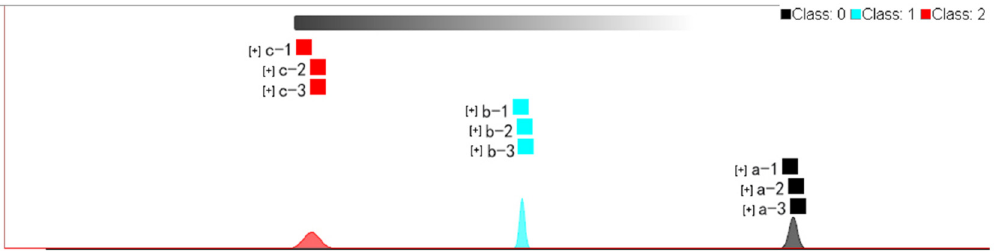
Figure 6. Fingerprint similarity based on Euclidean distance of different samples. a: Oil cistanche, b: blood cistanche, c: cistanche tubulosa in Xinjiang.